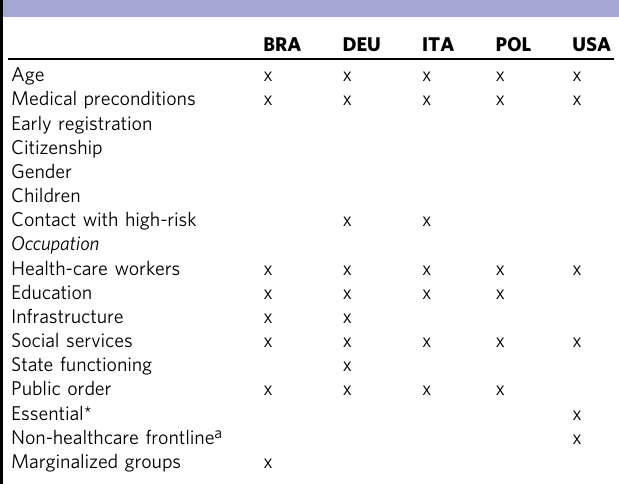
Table 1 Overview of initial national vaccination priority allocation ordinances in countries of study (as